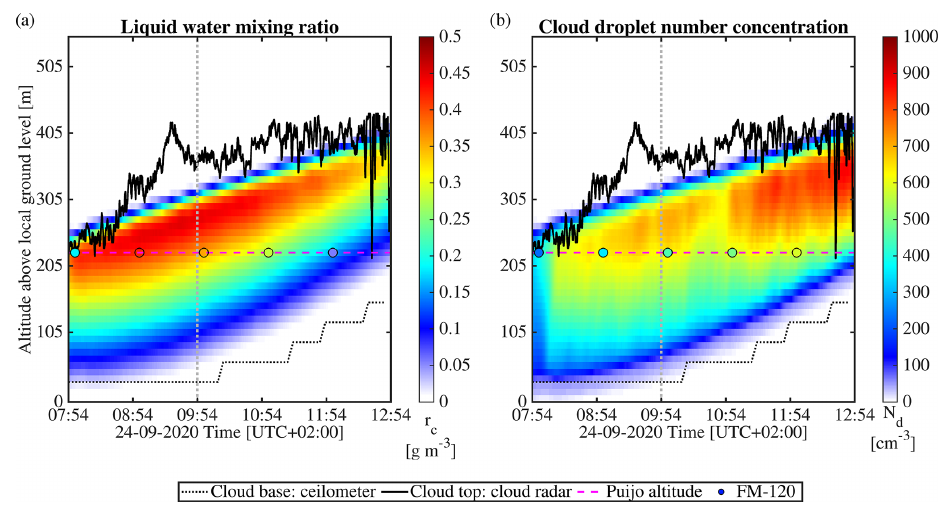
Figure 3. Comparison of cloud boundaries for case 1 – 24 September 2020 defined by modelled liquid water content and cloud boundaries retrieved from cloud radar and ceilometer observations. (a) Modelled vertical profiles of liquid water content and (b) model-based cloud droplet number concentrations. Both panels show observations at Puijo altitude from the fog monitor (FM-120). Model-based variables were calculated for the same droplet diameter range of the FM-120. Grey dotted vertical lines mark the third hour of the cloud event in each panel,